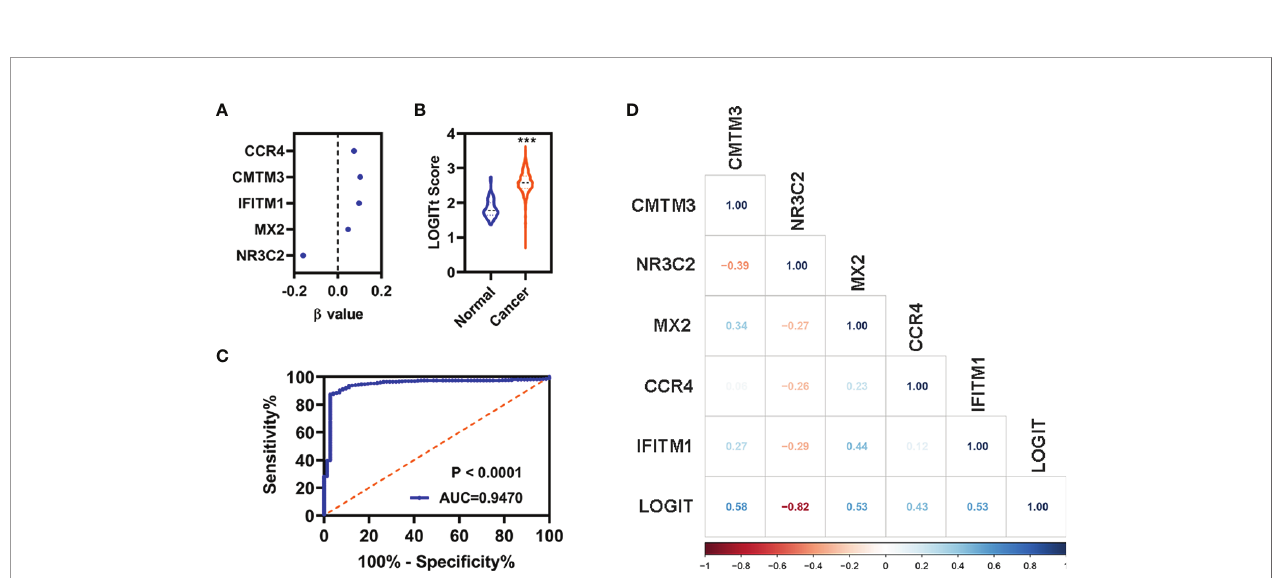
FIGURE 8 | Diagnosis model for distinguishing KIRC from normal in entire cohort. (A) The b value of these fi ve FI-DEGs analyses by stepwise logistic regression. (B) Diagnosis LOGIT values between normal and patients with KIRC. (C) ROC curves for evaluating the predictive performance of the diagnostic model. (D) Correlation analyses for the expression of these fi ve FI-DEGs and diagnostic model. N (normal) = 72, N (cancer) = 530. ***p <